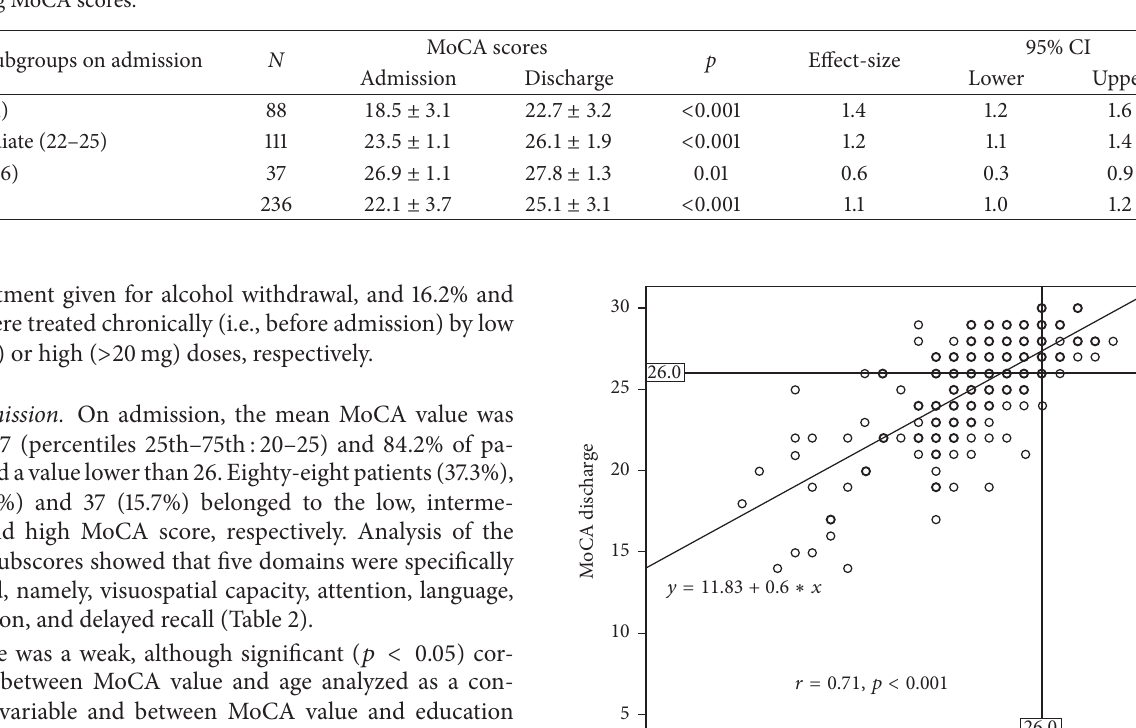
Table 2: MoCA scores and subscores on admission and discharge in the 236 patients studied. MOCA scores total